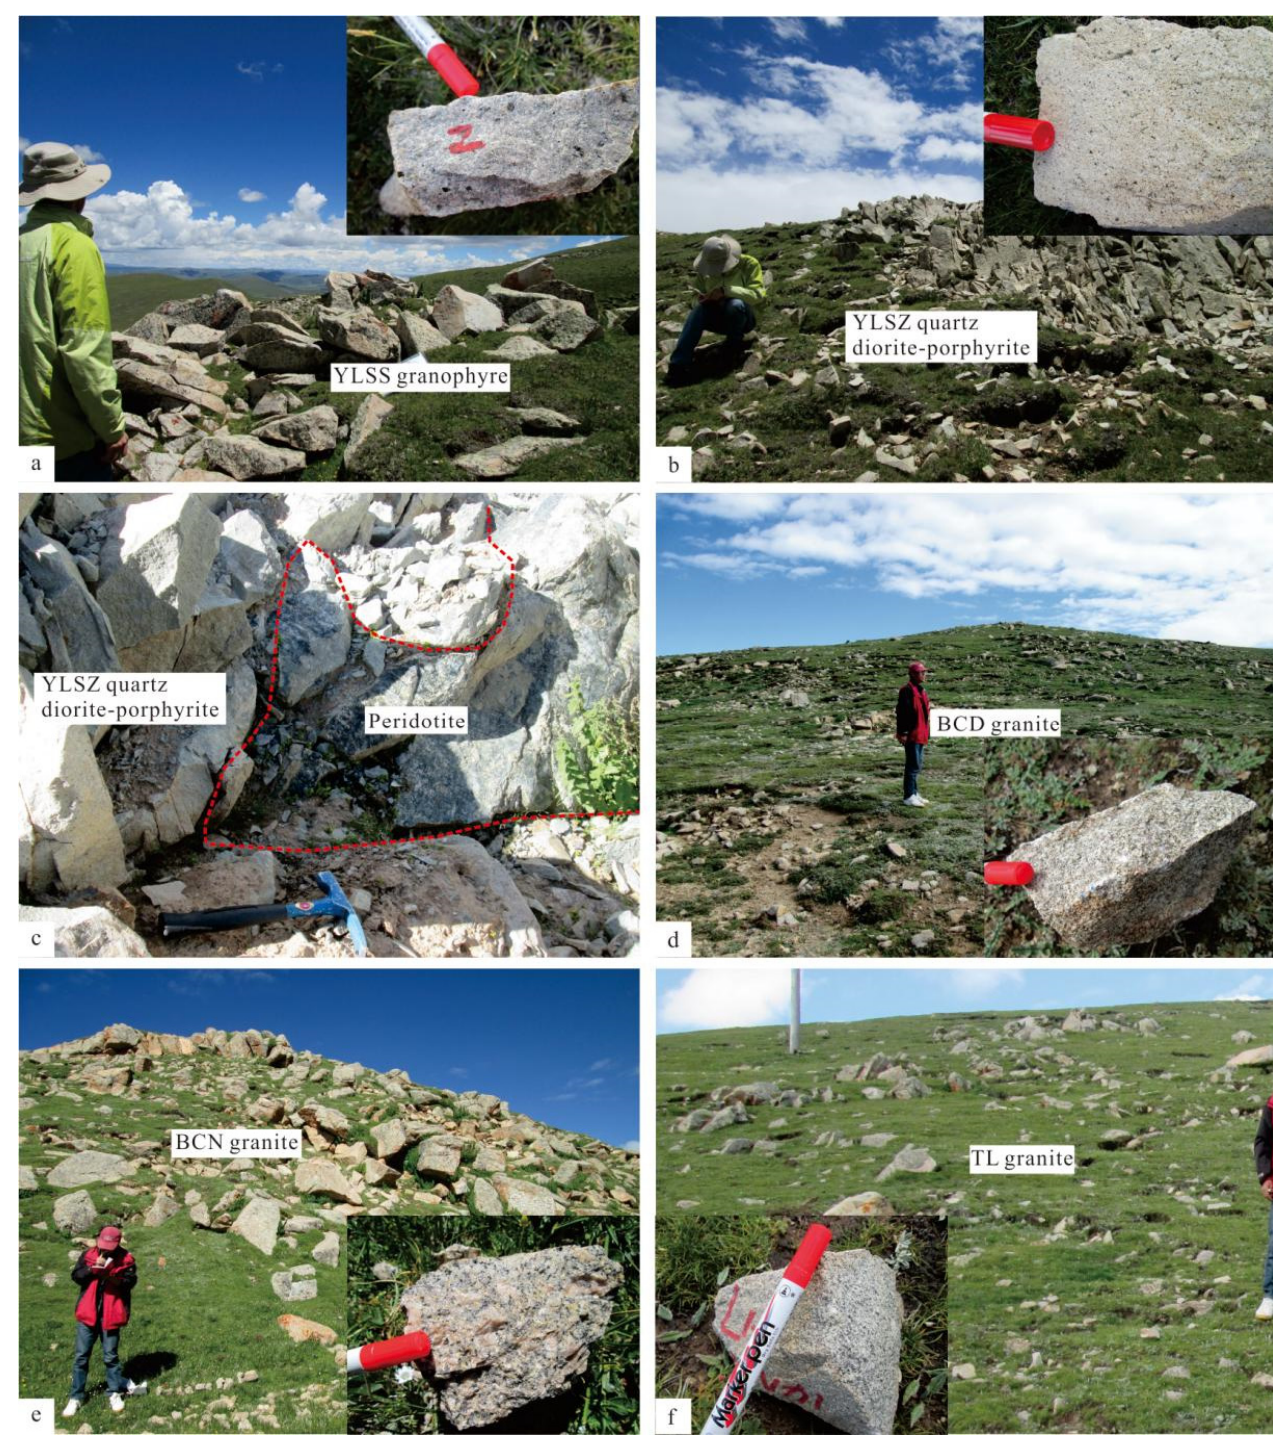
Figure 2. Field photographs of the Yilashan and Amdo granitoids in the Nagqu area. ( a ) YLSS granophyre; ( b ) YLSZ quartz diorite–porphyrite; ( c ) Peridotite intruded by the YLSZ quartz diorite–porphyrite; ( d – f ) Amdo BCD, BCN and TL granites.